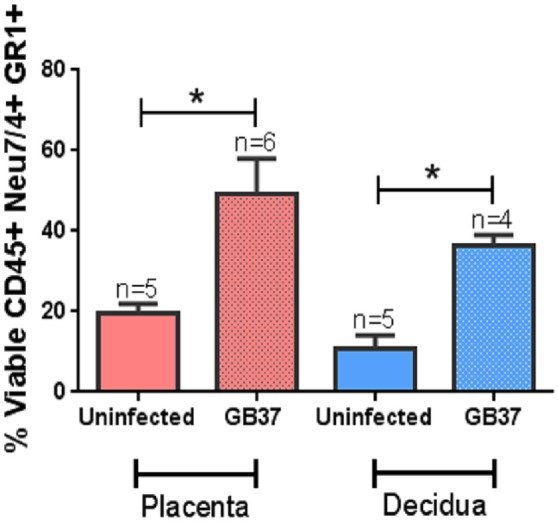
Flow cytometry analyses of placenta and decidua to evaluate the relative abundance of neutrophils. Neutrophils were evaluated by CD45+ Neu7/4+ GR1+ gating strategy on cells derived from the placental or decidual compartment of uninfected or GBS-infected pregnant mice. Bars represent mean percent (viable cells CD45+ Neu7/4+ GR1+) ± SEM. GBS-infection results in enhanced presence of neutrophils in the decidua and placenta (*P < 0.05 Student's t-test, N = 4–6).